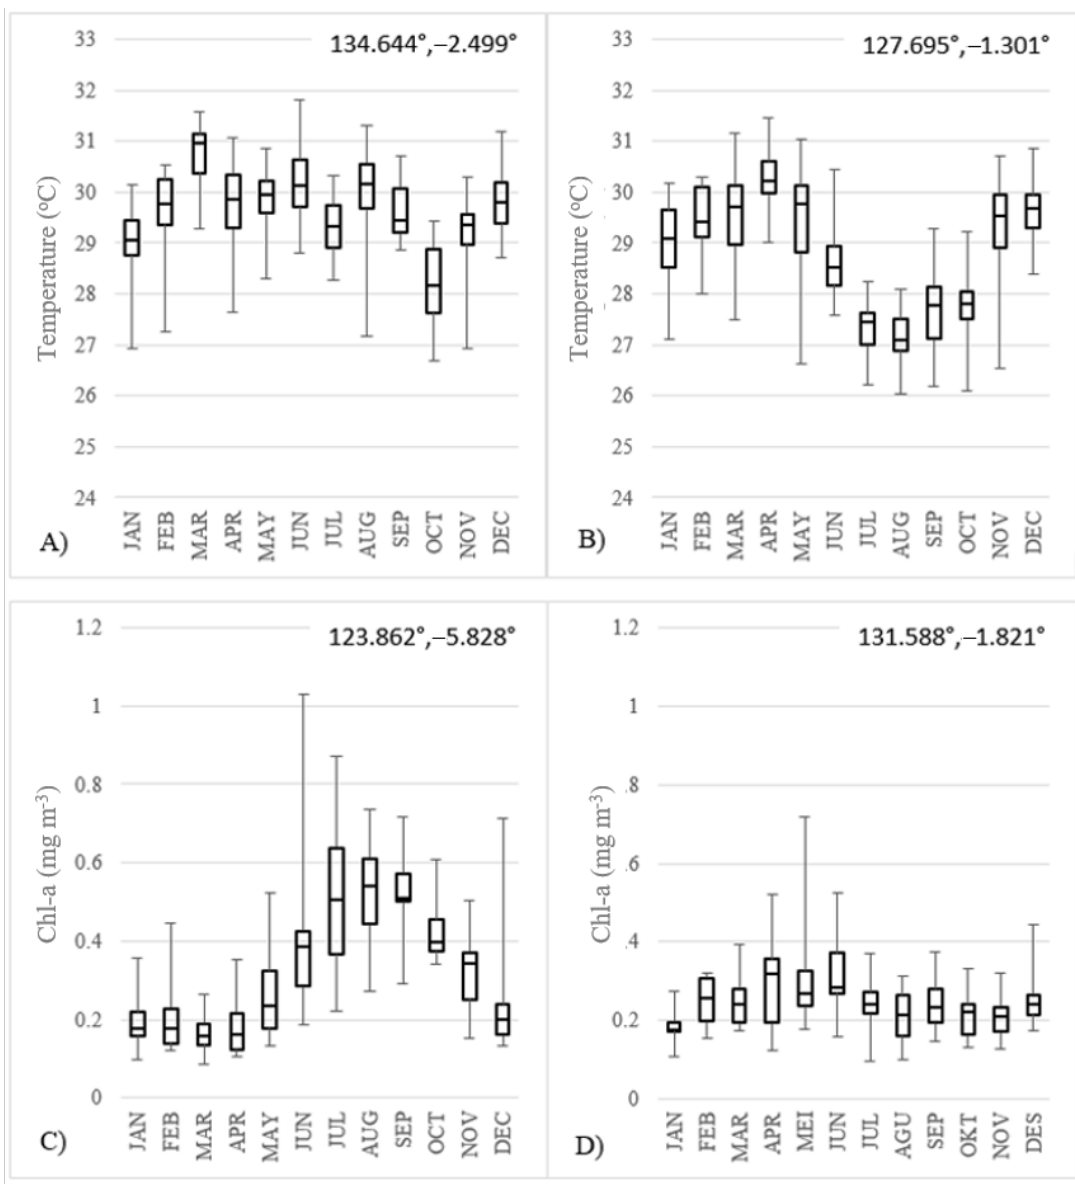
Figure 14. Average monthly increase and decrease in the SST and chlorophyll-a values during the La Niña and El Niño periods: ( A ) Increase in the SST during the La Niña period; ( B ) decrease in the SST during the El Niño period; ( C ) increase in the chlorophyll-a concentration during the El Niño period; ( D ) decrease in the chlorophyll-a concentration during the La Niña period.